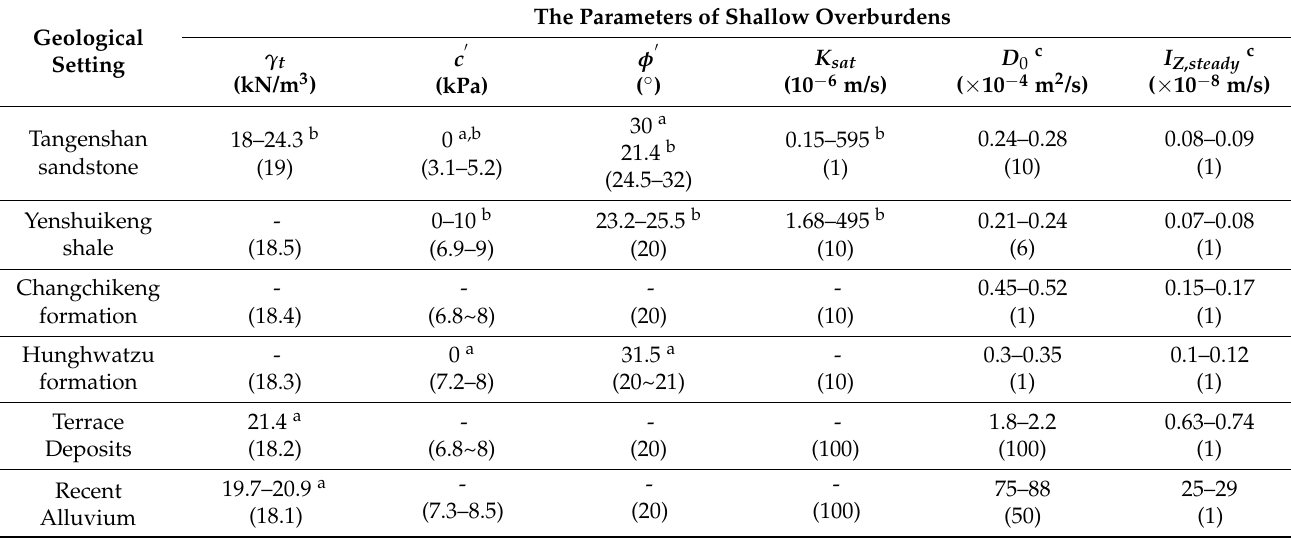
Figure 6. The calibrated parameter layers produced by the optimization reverse analysis: ( a ) Saturated hydraulic conductiv- ity; ( b ) Saturated hydraulic diffusivity; ( c ) Soil cohesion for effective stress; ( d ) Soil friction angle for effective stress. Table 3. The hydrogeological measured and calibrated parameters of shallow overburdens in the Xiaolin